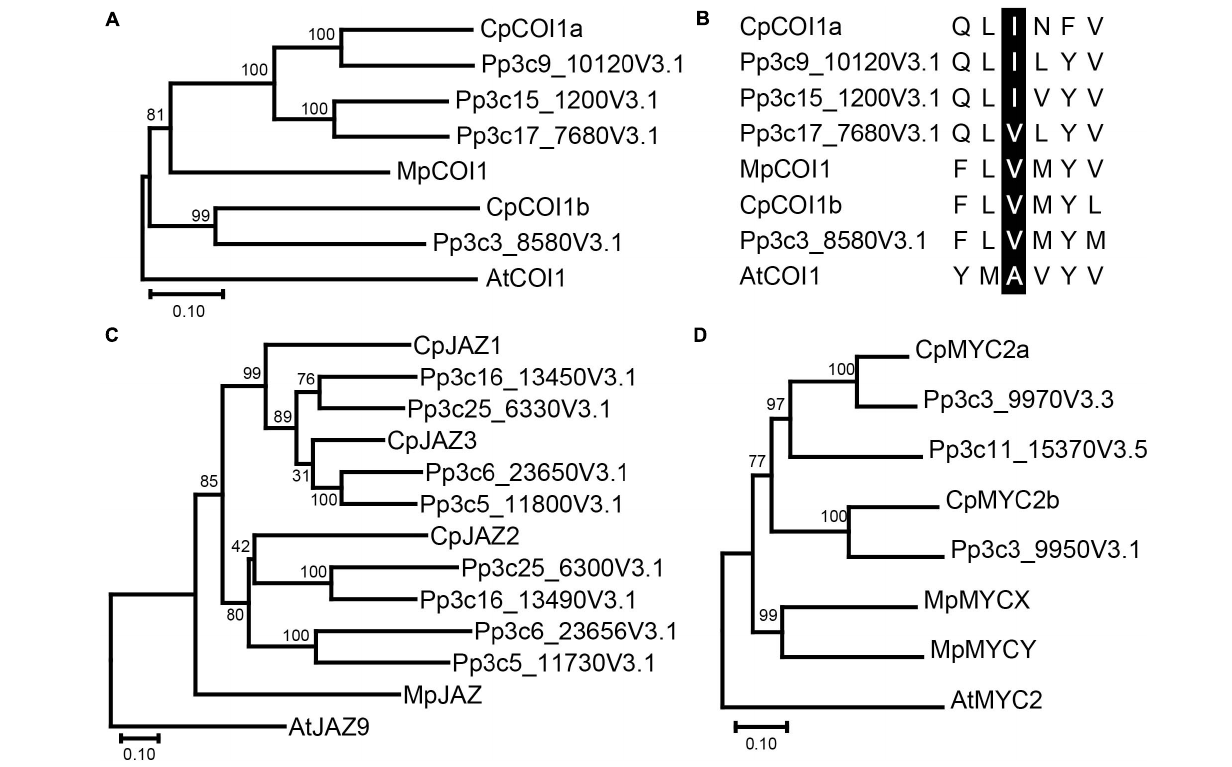
FIGURE 1 | Phylogenetic analysis of COI1 (A) , JAZ (C) , MYC2 (D) homologs, and the residue essential for dn-OPDA and dn- iso -OPDA recognition (B) . (A) Phylogenetic trees (amino acid sequences) were obtained using the neighbor-joining method as described in the “Materials and Methods.” The percentage of replicate trees in which the associated taxa clustered together in the bootstrap test (1000 replicates) is shown next to the branches. COI1 homologs in M . polymorpha and P. patens are also included. The phylogenetic tree was rooted in AtCOI1. Gene IDs are as follows: MpCOI1: Mapoly0025s0025 and AtCOI1: AT2G39940. (B) The amino acid sequence of the valine residue at position 377 (V377) of MpCOI1 and its surroundings is shown with the corresponding sequences of other COI1 homologs. V377 in MpCOI1 and its corresponding residues in other COI1 homologs are highlighted by black. (C) Phylogenetic trees (amino acid sequences) were obtained using the neighbor-joining method as described in the “Materials and Methods.” The percentage of replicate trees in which the associated taxa clustered together in the bootstrap test (1000 replicates) is shown next to the branches. JAZ homologs in M . polymorpha and P. patens are also included. The phylogenetic tree was rooted in AtJAZ9. Gene IDs are as follows: MpJAZ: Mapoly0097s0021 and AtJAZ9: AT1G70700. (D) Phylogenetic trees (amino acid sequences) were obtained using the neighbor-joining method as described in the “Materials and Methods.” The percentage of replicate trees in which the associated taxa clustered together in the bootstrap test (1,000 replicates) is shown next to the branches. MYC2 homologs in M . polymorpha and P. patens are also included. The phylogenetic tree was rooted in AtMYC2. Gene IDs are as follows: MpMYCX: Mapoly0018s0019; MpMYCY: MapolyY_B0018; and AtMYC2: